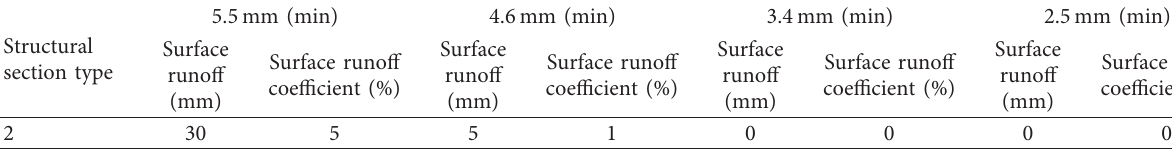
Table 5: Surface runoff coefficients at different rainfall intensities.